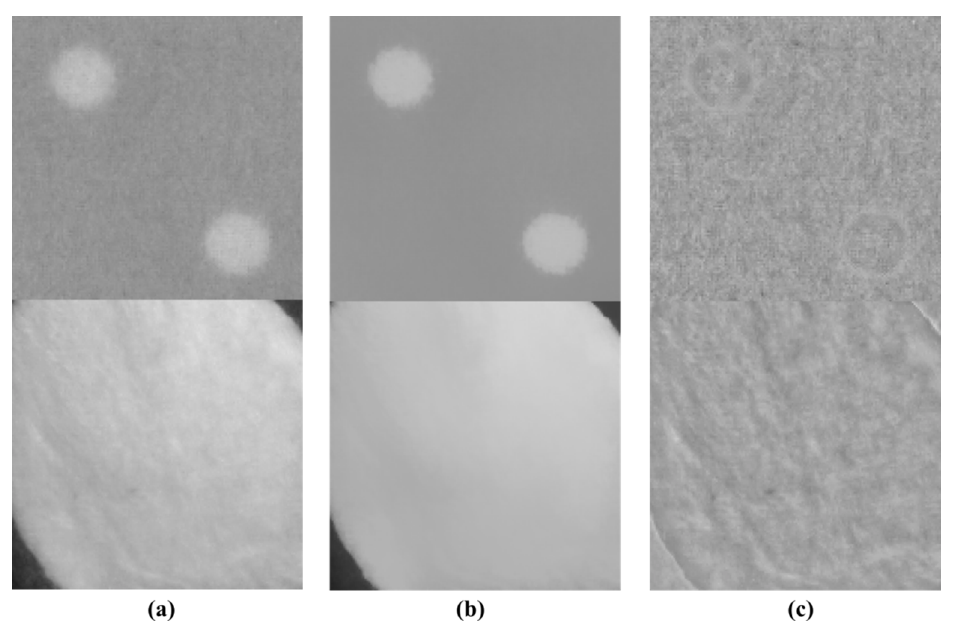
Figure 5. Examples of texture component and smoothness component decomposition: ( a ) Original images; ( b ) smoothness components of original images; ( c ) texture components of original